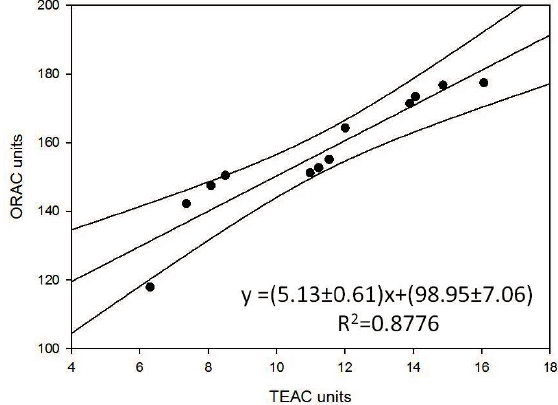
Figure 6. Correlation curve between the spectrophotometric and SOD biosensor methods.